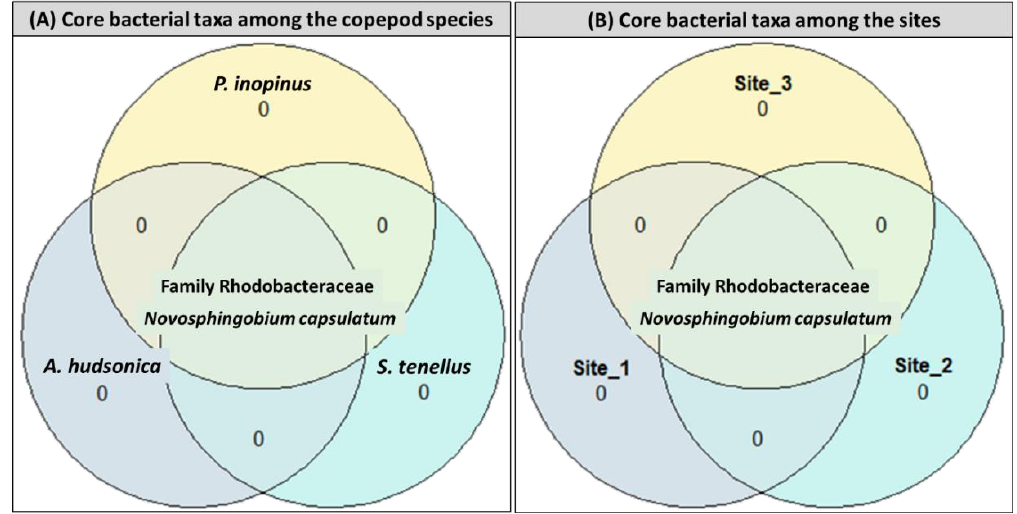
Figure 6. Shared and unique core taxa in the gut bacterial communities among ( A ) copepods ( Acartia hudsonica , Sinocalanus tenellus , and Pseudodiaptomus inopinus ) and ( B ) sites using Venn diagrams; core taxa were selected based on 0.001 detection probability in at least 90% samples and prevalence = 0.75.